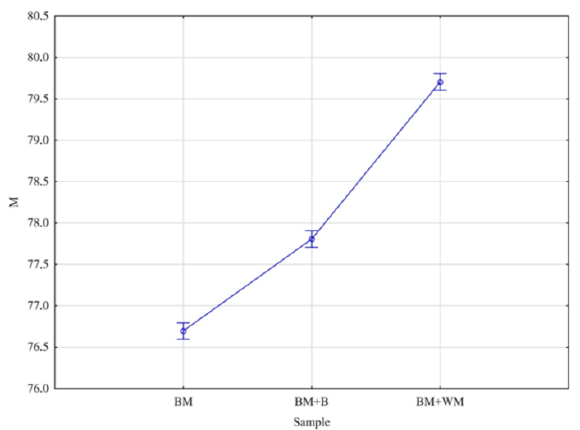
Figure 9. Mean contents of ash (M) in BSG.